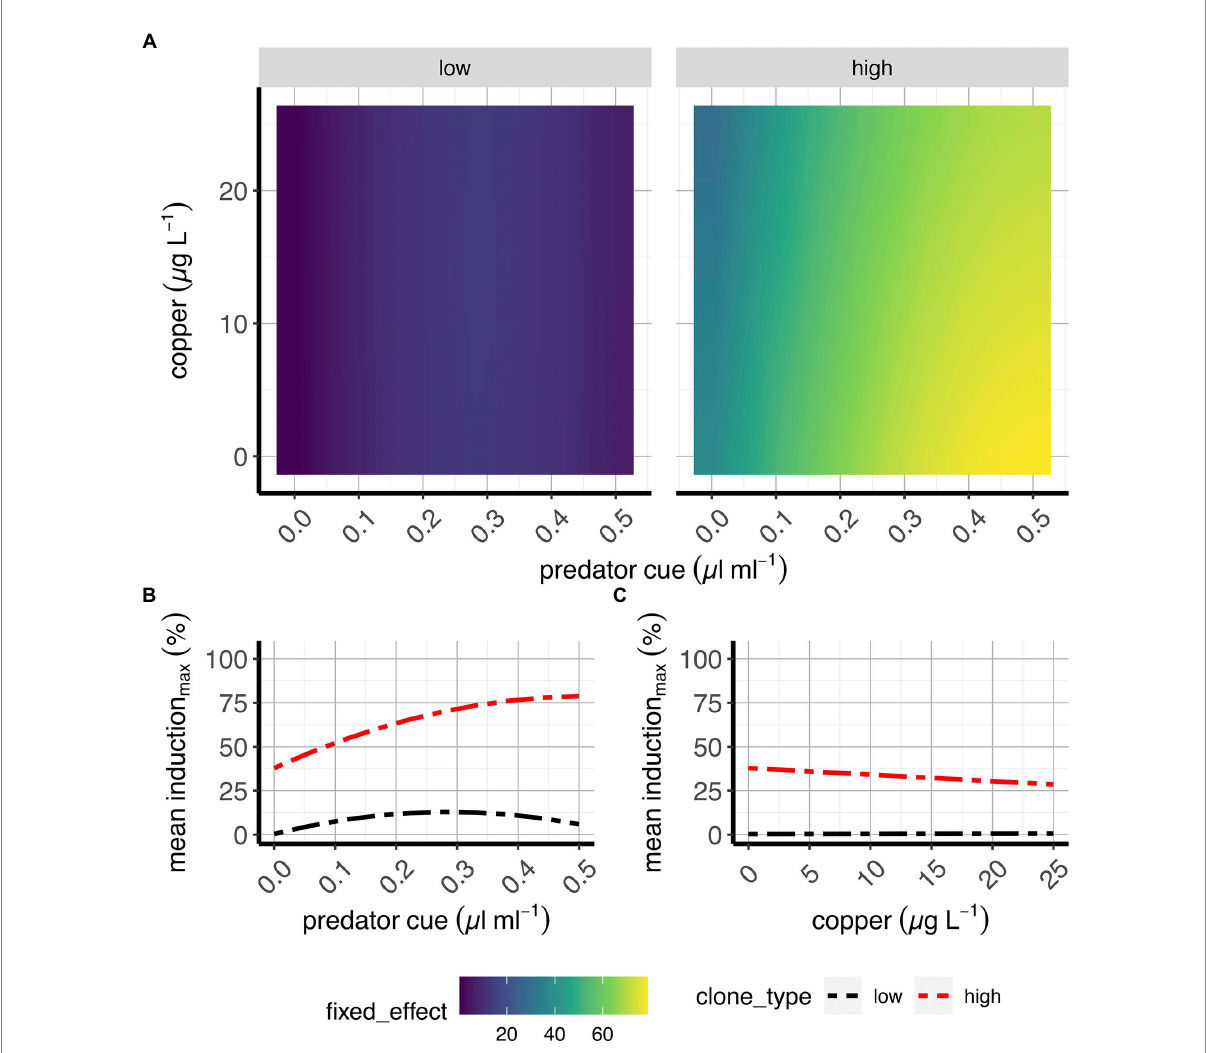
FIGURE 2 Morphological induction in two classes of D. pulex genotypes. (A) Contour plots of the average fixed effects portion of the model showing the overall morphological changes to copper and predation in “high inducers” and “low inducers.” (B,C) Average effects of risk of predation (B) and sub-lethal copper concentrations (C) on morphological induction when copper and risk of predation, respectively, are absent (e.g., references for each treatment). X-axes present predator cue (A,B) or copper concentrations (C) , and y-axis denote copper concentrations (A) or morphological induction estimates (B,C)